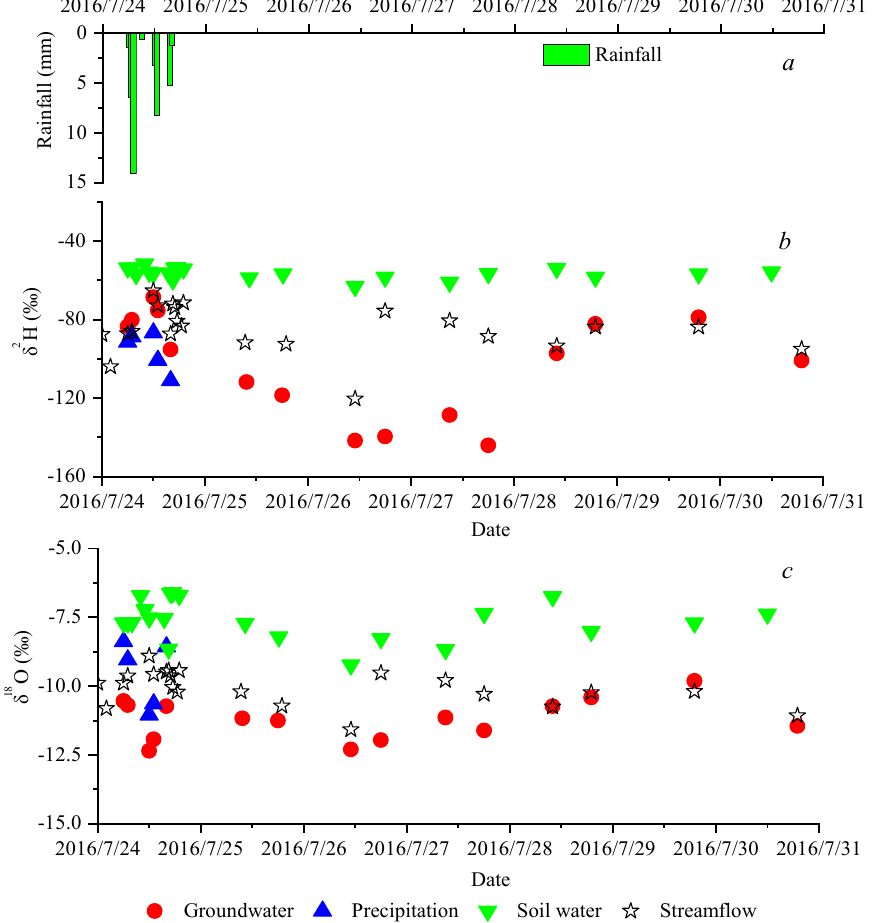
Figure 3. The variation of rainfall ( a ) and isotopic values ( b , c ) with respect to precipitation, stream water, groundwater, and soil water during the experiment.